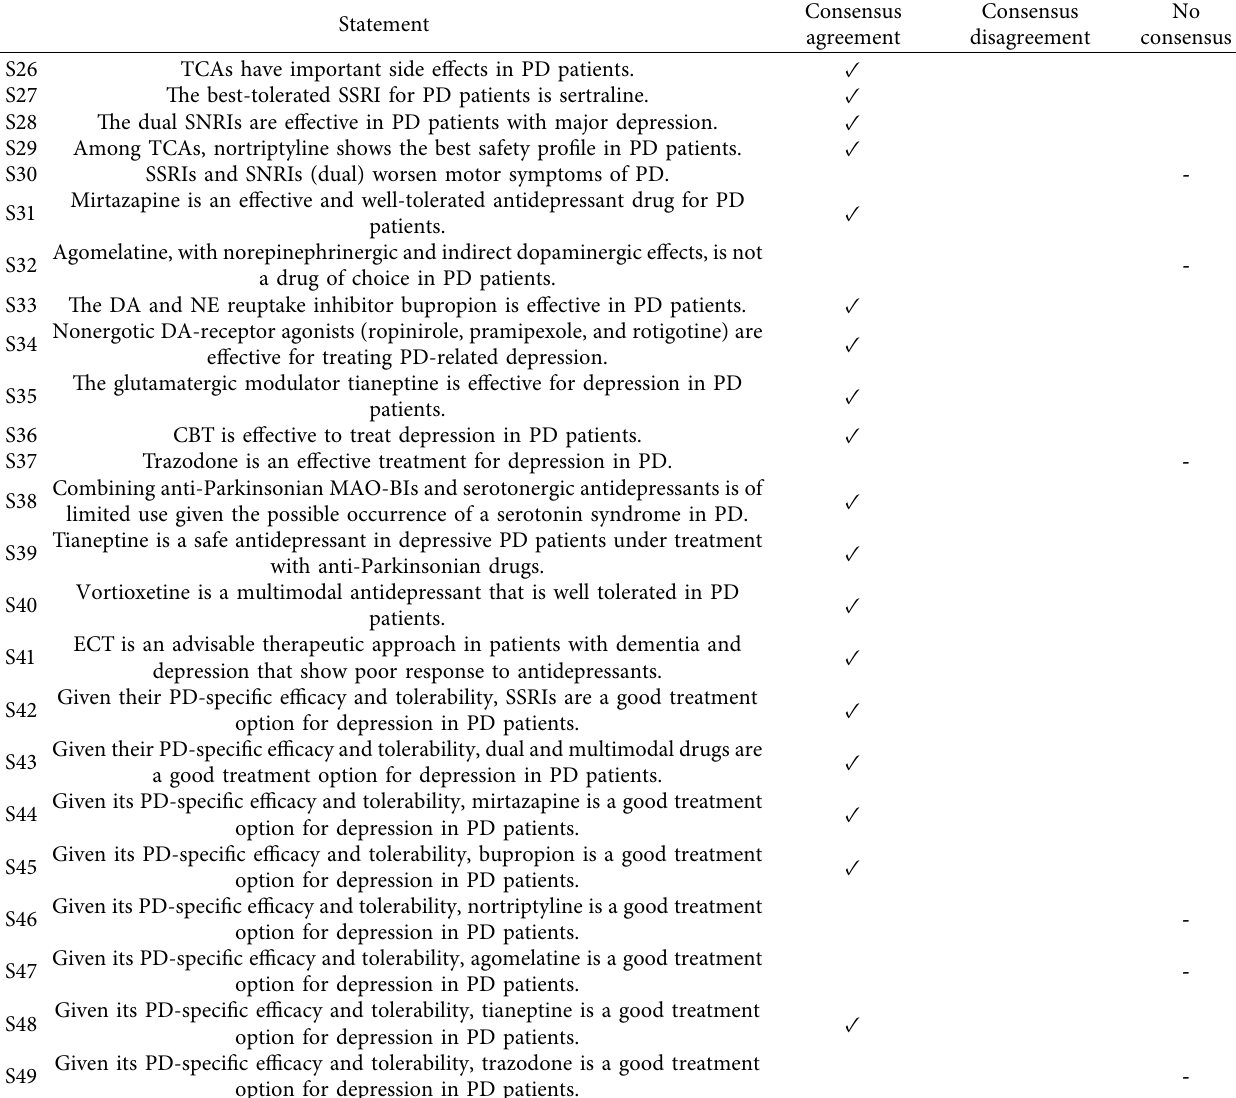
Table 4: Section IV: treatment of depression in PD